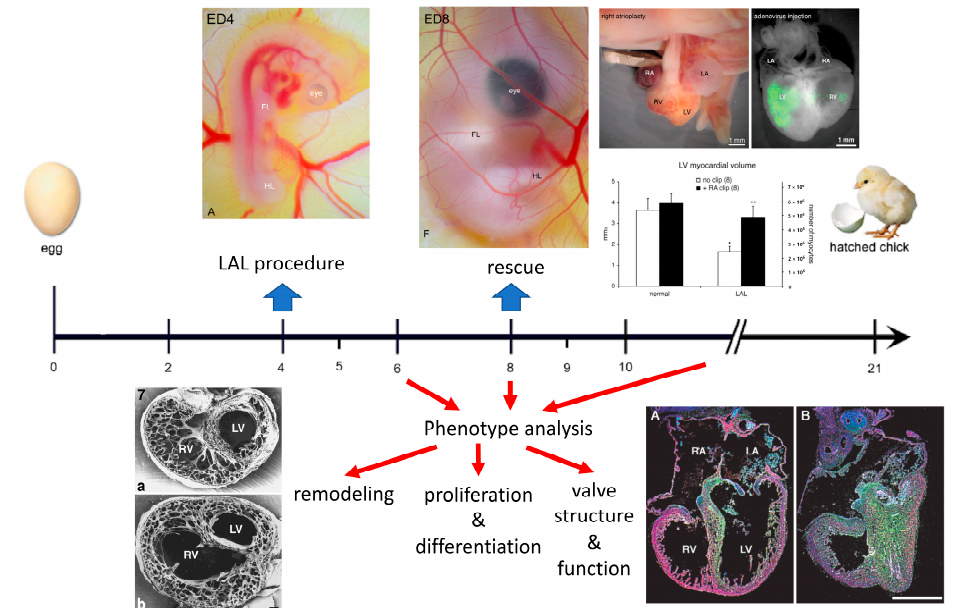
Figure 1. Scheme of the workflow for creating the chick model of HLHS and examples of phenotypic findings (below the time axis in days) and rescue attempts (top right). From references [1,6,8–10]. The time axis shows embryonic days; the heart starts to beat before ED2, develops trabeculae at ED3, completes ventricular septation at ED8, and completes functional coronary vasculature by ED9. The panels above the axis show the appearance of the chick embryo at ED4 and ED8 [8], rescued ED9 heart with a silver microclip on the right atrium, green fluorescence protein expression in the embryonic left ventricle confirming successful injection of the adenovirus [1], and the graph shows the increased myocardial volumes in the right atrial clip rescue experiment [9]. The bottom panels show the phenotype on transverse sections in the scanning electron microscopy 48 h after ligation (left) [6], and decreased myocyte proliferation demonstrated by increased retention of radiolabeled [3H]-thymidine [10] (green grains over the hypoplastic left